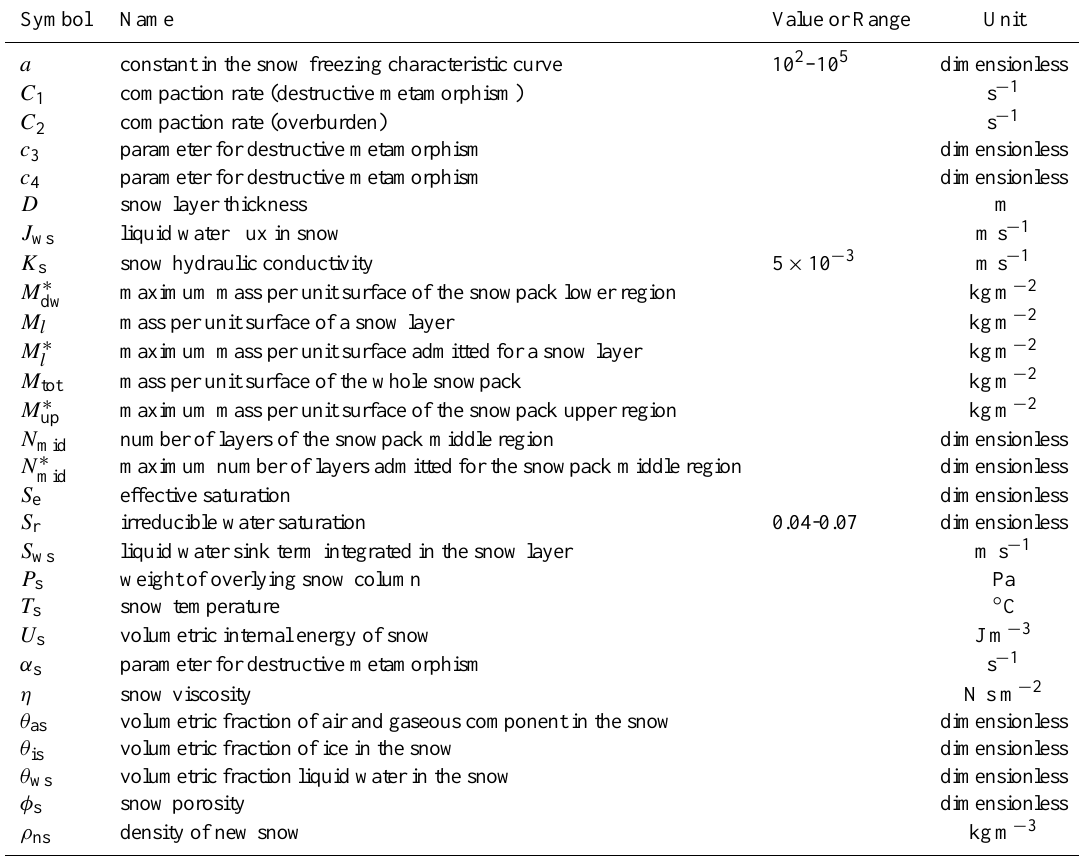
Table D5. Table of symbols for the